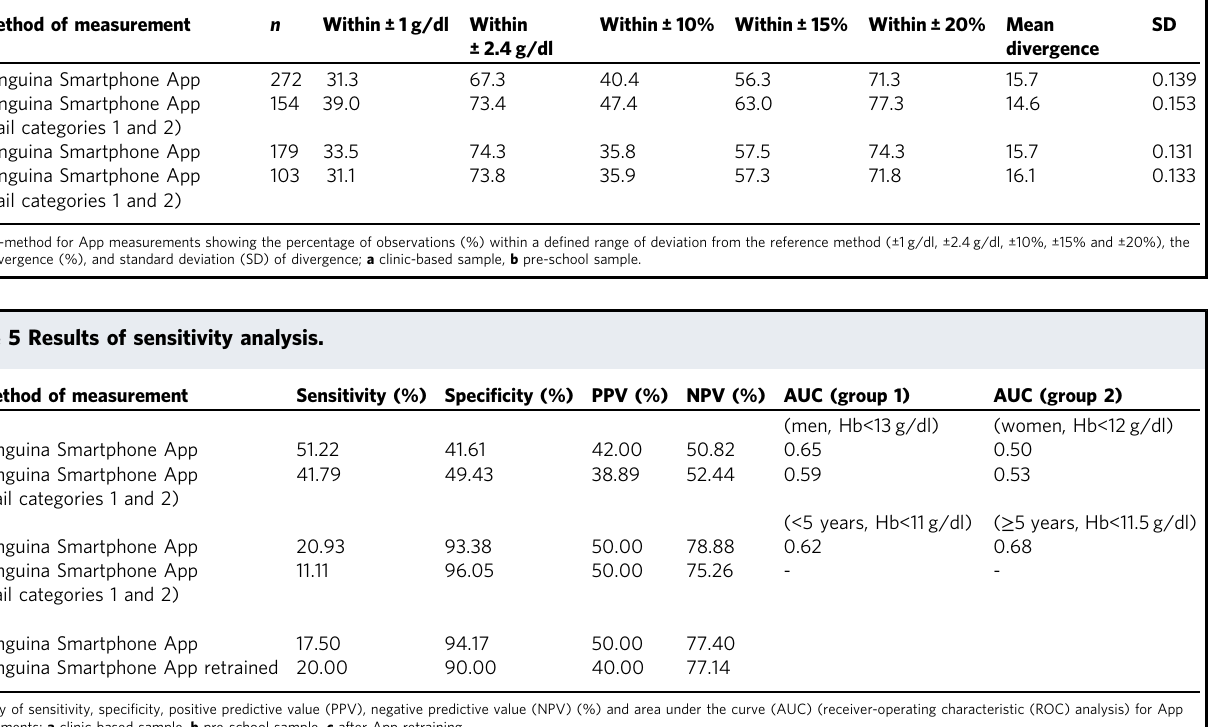
Table 4 Results of in-range-method. Method of measurement